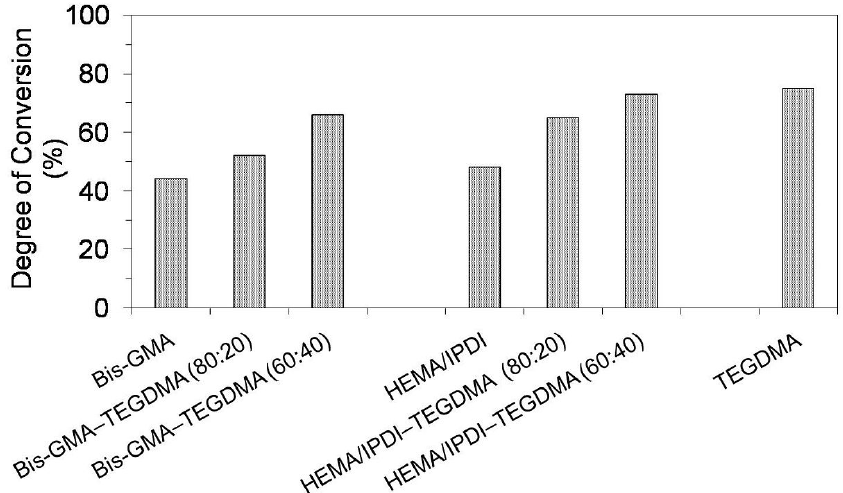
Figure 1. The degree of conversion in Bis-GMA, HEMA/IPDI and TEGDMA